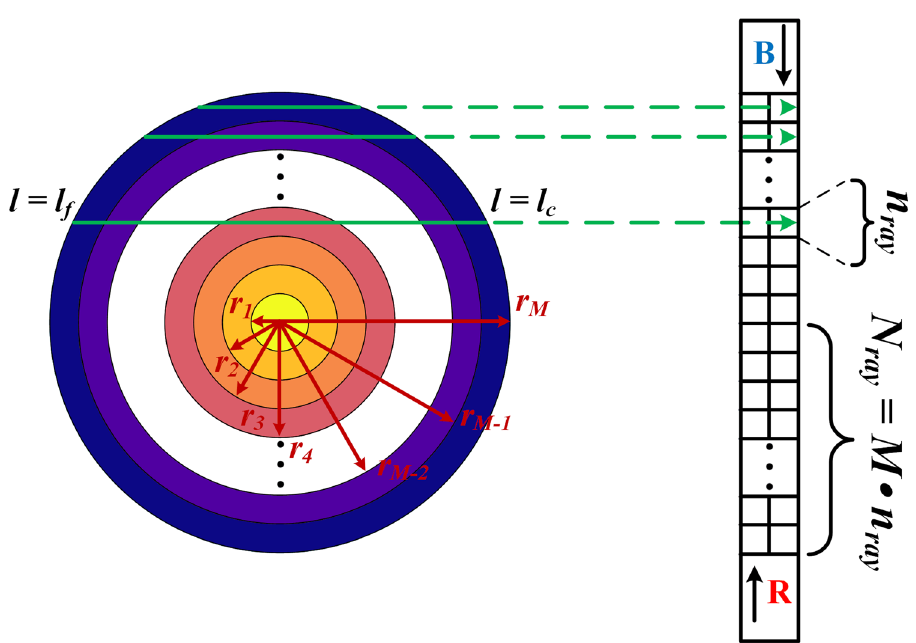
Figure 1. Reconstruction system schematic diagram on a muzzle flash